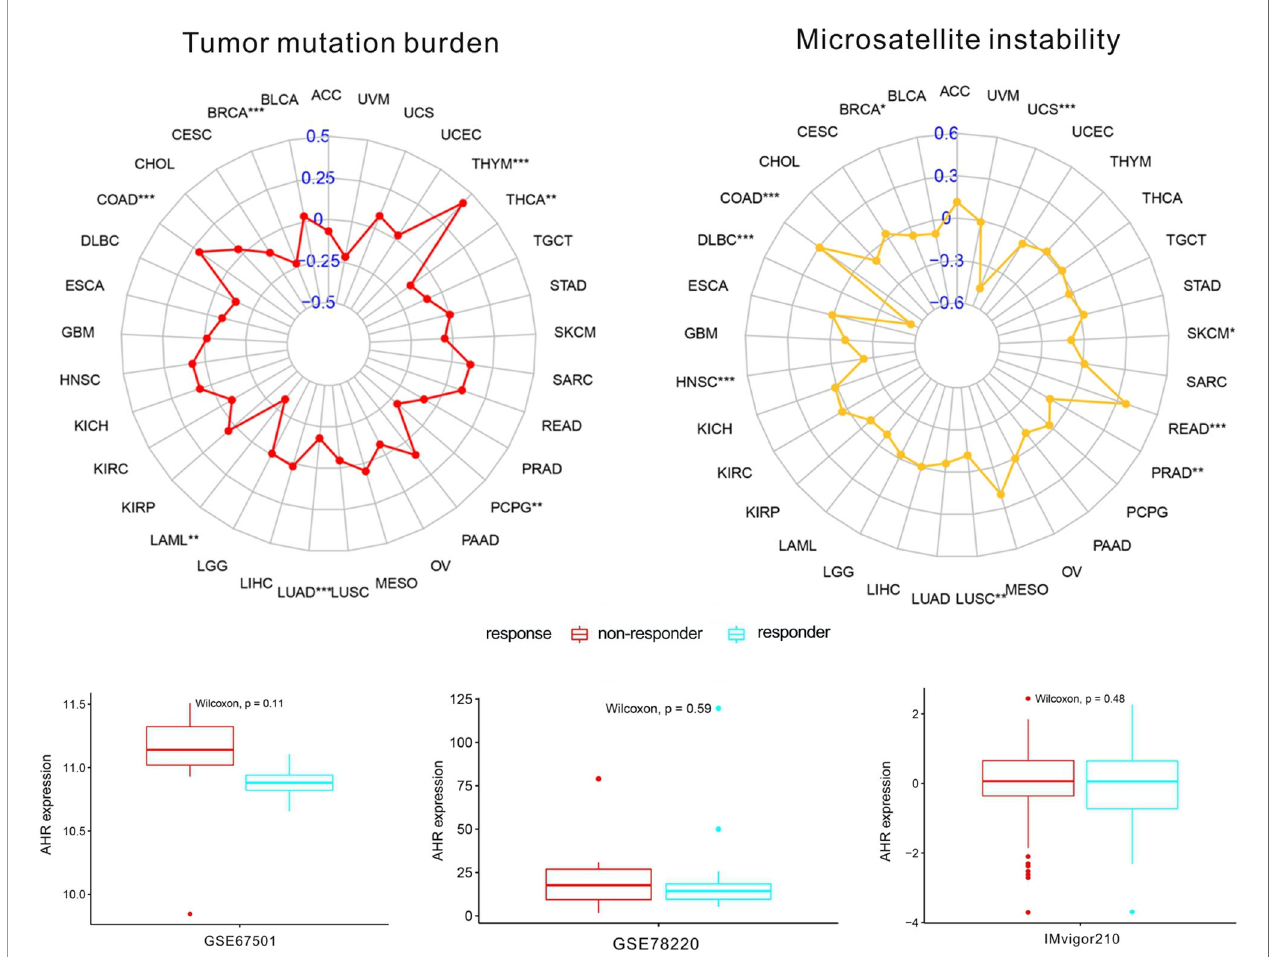
FIGURE 10 | The correlation between AhR and both immunotherapeutic markers and the immunotherapeutic response. “ * ” indicates p < 0.05, “ ** ” indicates p < 0.01 and “ *** ” indicates p <